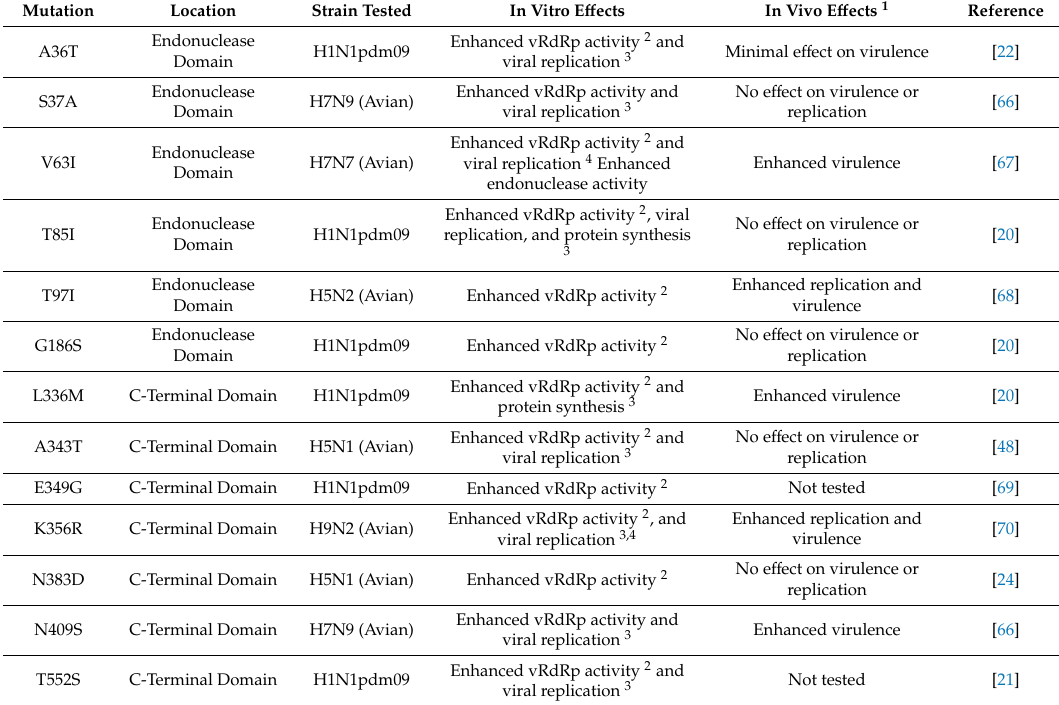
Table 1. List of experimentally verified host adaptive avian to mammalian mutations in